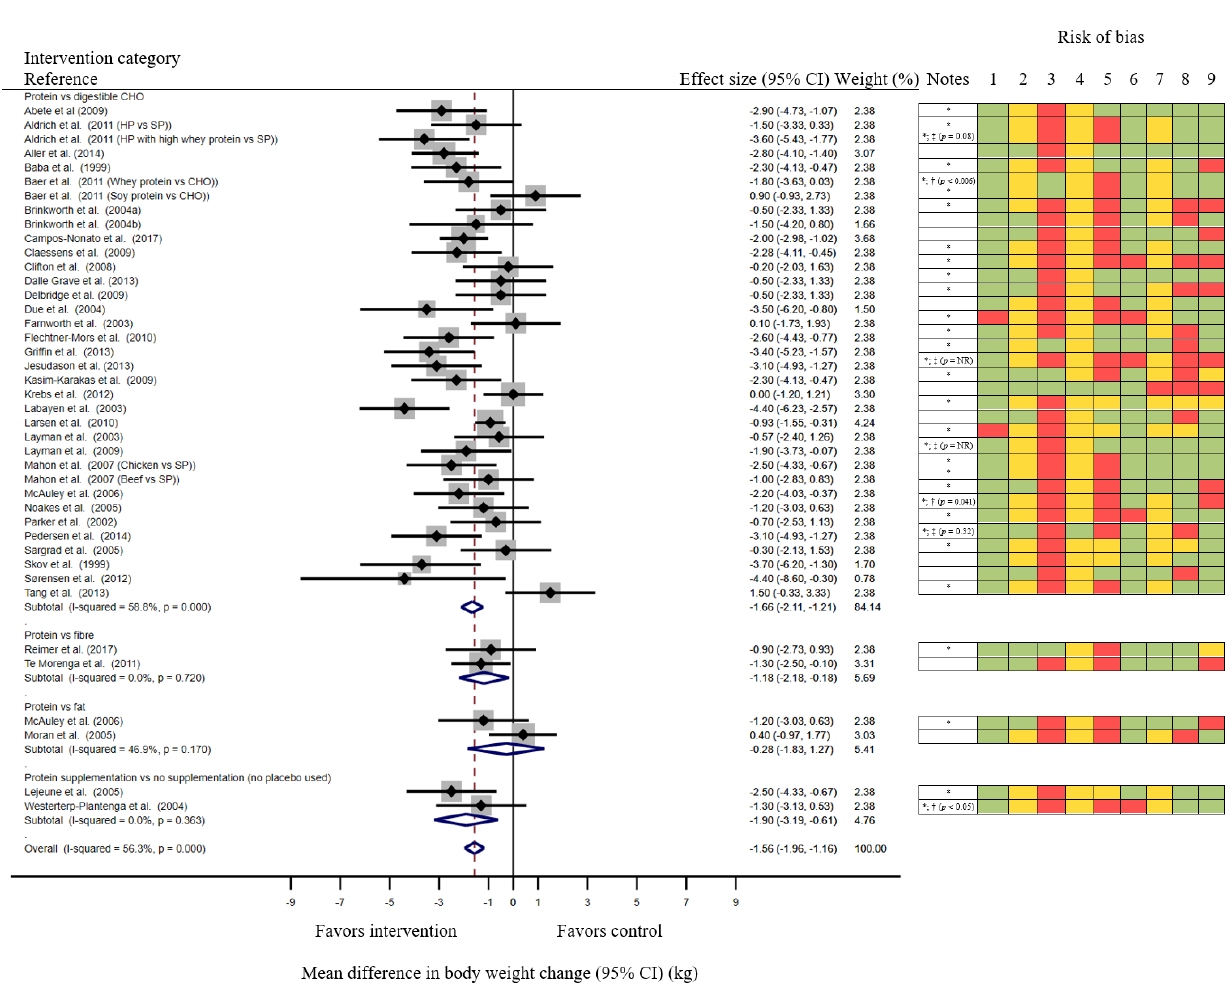
Figure 2. Meta-analysis of mean difference in body weight changes with 95% CI (kg) between exposures to various interventions increasing protein intake compared to controls. CHO, carbohydrate; CI, confidence interval; HP, high protein (30 E%), NR, not reported; SP, standard protein (range: 15–16 E%); *, 95% CI imputed based on the average standard error of mean from the other studies [28]; †, Imputation of 95% CI causes non-significant difference despite significant difference is reported in the original paper; ‡, Imputation of 95% CI causes significant difference despite non-significant difference being reported in the original paper.